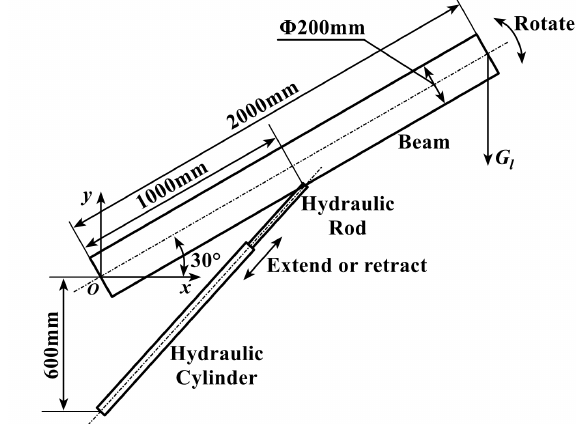
Figure 3. Mechanical system.